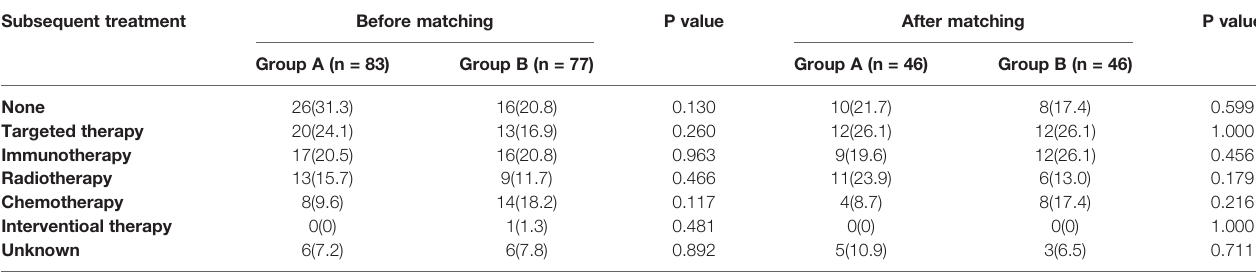
TABLE 4 | Subsequent treatment after the progression of anlotinib